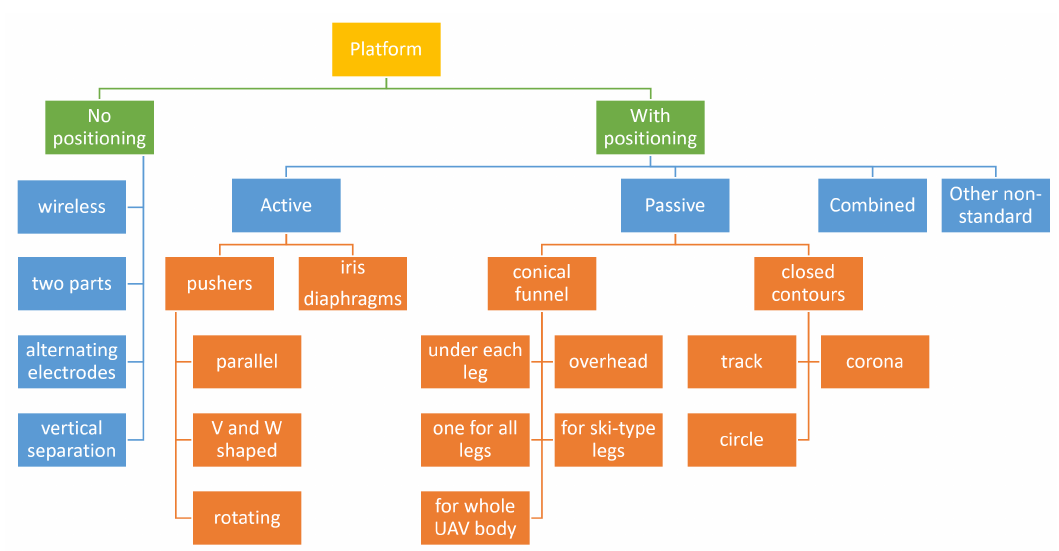
Figure 1. Classification of approaches for UAV positioning in landing